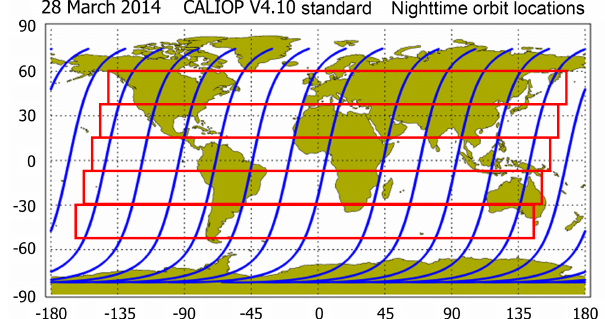
Figure 14. Nighttime orbit tracks for 28 March 2014 (in blue), overlaid with notional averaging domains (red boxes) that extend over two time dimensions; i.e., traveling along track (north–south) within individual granules, and spanning the same along-track dis- tance across multiple granules